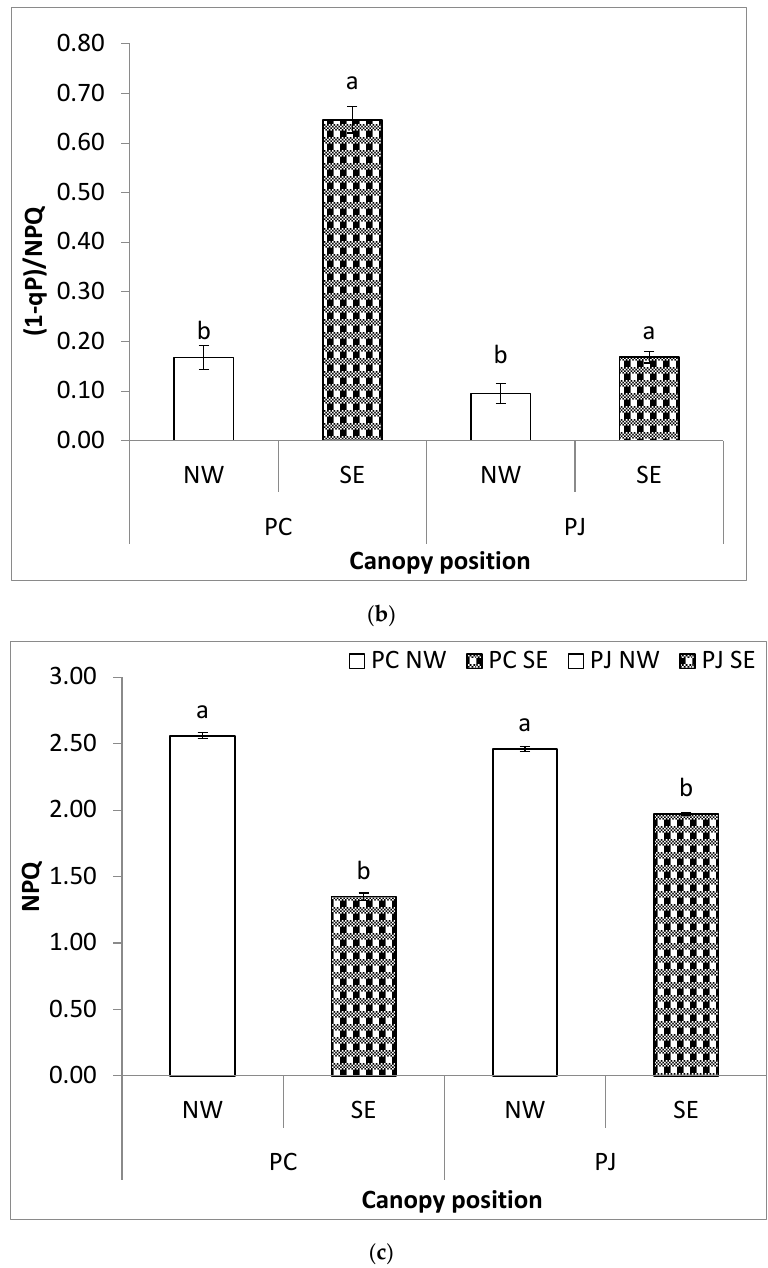
Figure 4. Changes in fluorescence quenching coefficients ( a ) qP, ( b ) non-photochemical fluorescence quenching (NPQ), and ( c ) heat energy dissipation (1-qP)/NPQ in Prosopis juliflora and Prosopis cineraria leaves from different canopy position (south east, SE; north west, NW). Every column in each bar represents the mean (± S.E.) of the three replicates. Means with the same letters with a species indicates insignificant differences between the two canopy positions at p >0.05 according to Duncan Multiple range test. There was significant difference in heat energy dissipation (1 − qP)/NPQ between P. juliflora and P. cineraria on both canopy positions. On the SE canopy position of P. cineraria , the heat energy dissipation (1 − qP)/NPQ, was increased by 60.09% ( p > 0.05) as compared to NW, respectively, (Figure